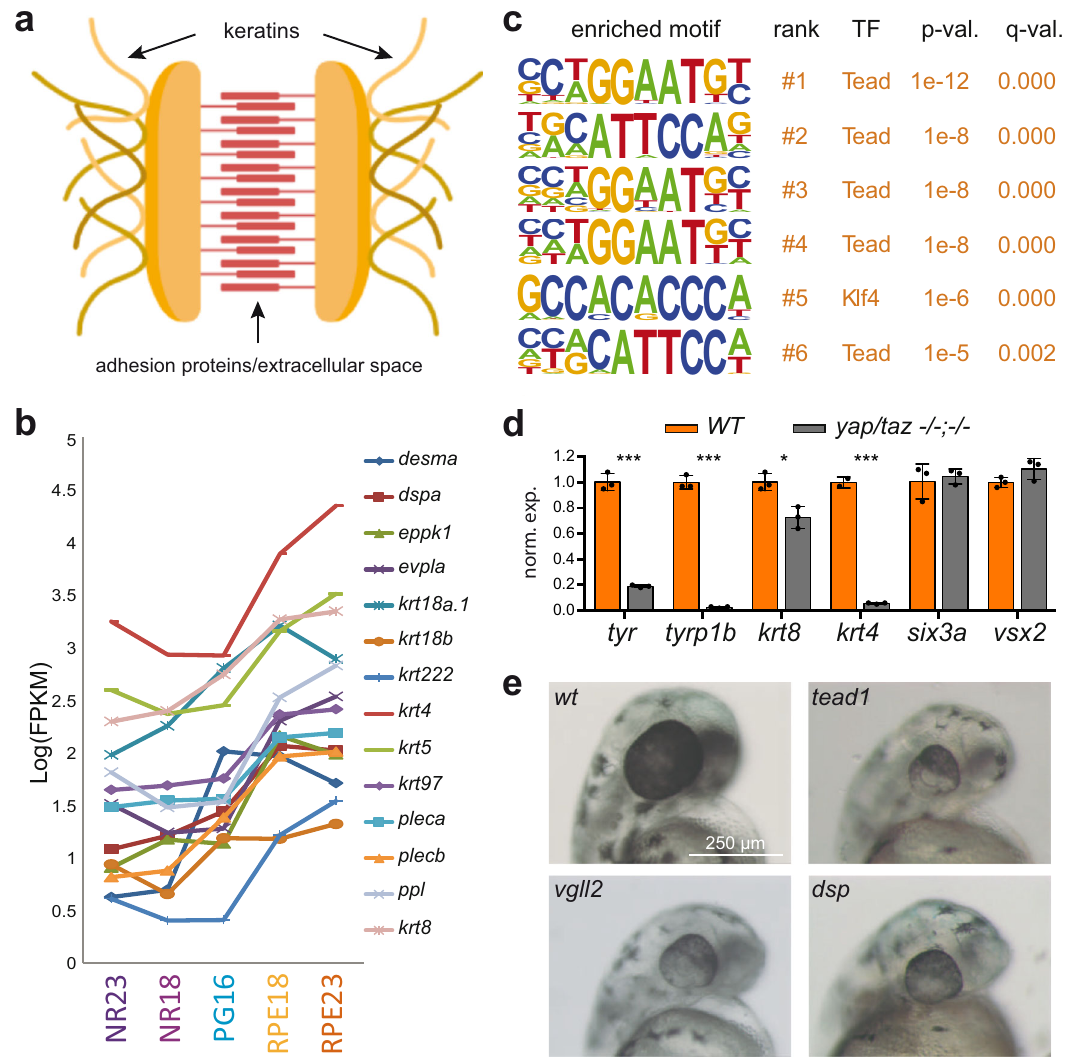
Fig. 7 Regulation of desmosomal components during RPE speci fi cation. a Schematic representation of a desmosome junction. b Intermediate fi lament and desmosomal gene expression variations during optic cup development. Expression values are reported as log(FPKM). c Motif enrichment analysis of the DOCRs associated with genes encoding intermediate fi lament or desmosome components. d mRNA levels of keratin genes as well as RPE and NR markers as determined by RT-qPCR in wild type and yap − / − taz − / − double mutant zebra fi sh samples (dissected heads) at 18 hpf. Signi fi cant differences are indicated ( n = 3; Two-tailed T -test; *** = p < 0.001; * = p < 0,05. p values: tyr = 3.4e − 5; tyrp1b = 6e-6; krt8 = 1.2e − 2; krt4 = 3.1e − 5; six3a = 0.67; vsx2 = 0.12). Data are presented as mean ± SD. Source data are provided as a Source Data fi le. e Representative stereo microscope images of zebra fi sh embryo heads at 48 hpf: wild type and embryos injected with Cas9 (300 ng/ μ l) together with the following sgRNAs (80 ng/ μ l) combinations: vgll2a and vgll2b (vgll2) ; tead1a and tead1b (tead1) and dspa and dspb (dsp ) . Magni fi cation Bar = 250 µ m. The same magni fi cation was used for each image in the series . Note the reduced eye size and RPE hypopigmentation in the crispants. Injections were repeated twice with similar results. See also Supplementary Fig.